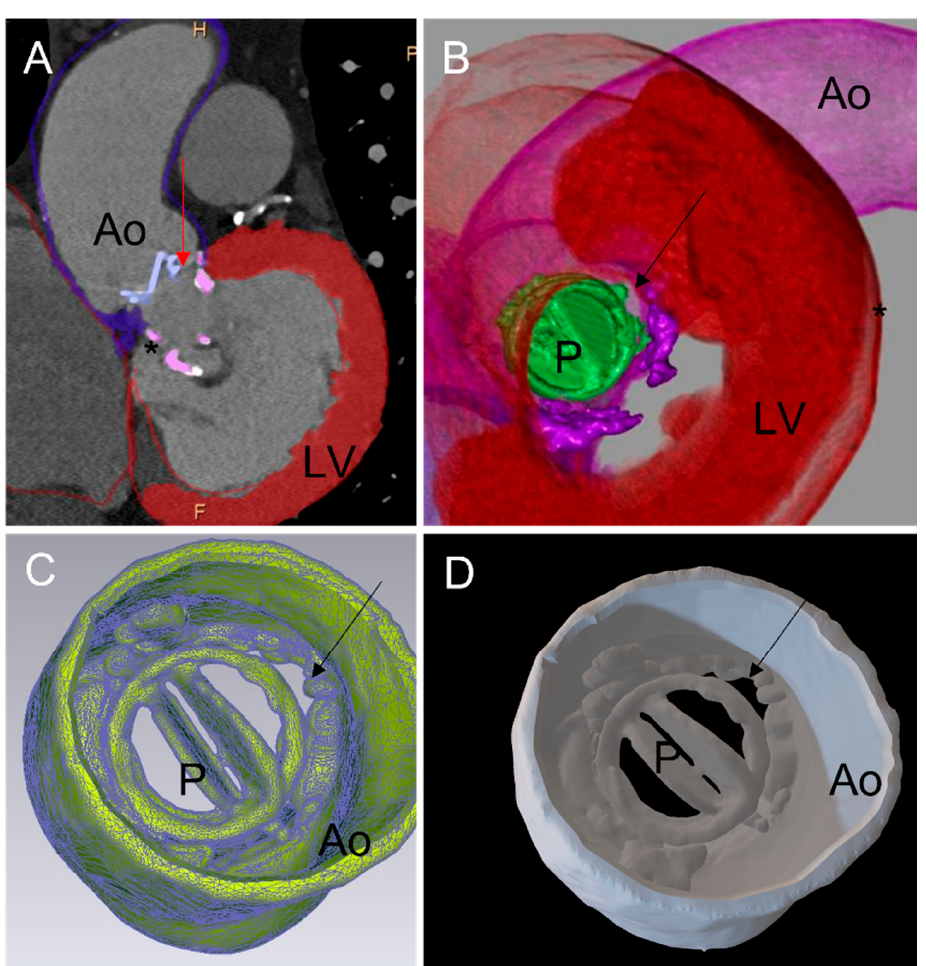
Figure 1. Three-dimensional printing workflow: ( A ) 2D cardiac tomography (CT). Each cardiac structure of interest has been segmented: aortic wall, mechanical aortic valve prothesis, left myocardium, annular calcification (*). A diastasis is observed between the mechanical aortic prosthesis (P) and the aortic wall (Ao) corresponding to a paravalvular leak (PVL) (red arrow). ( B ) CT full volume rendering of the segmented structures. The mechanical aortic valve is displayed in green. The PVL is seen from a left ventricular view. ( C ) A standard triangle language (STL) file was created from segmented structures. The PVL is seen from the aorta (black arrow). ( D ) Three-dimensionally printed model derived from the STL. Visualization of the aortic root, aortic valve (P) and the PVL (black arrow). PVL: paravalvular leak; Ao: aortic; LV: left ventricle; P: